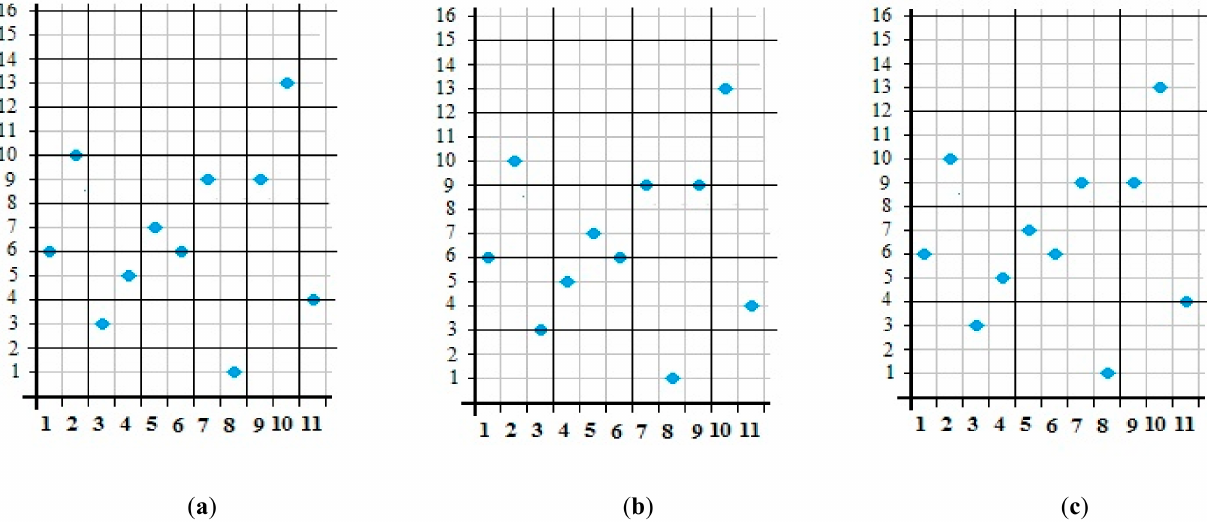
Figure 3. A set of grids superimposed on a graphic image of the sequence. Here, the graph markers indicate the number of letters in the word sequence: 2—( a ), 3—( b ), 4—( c